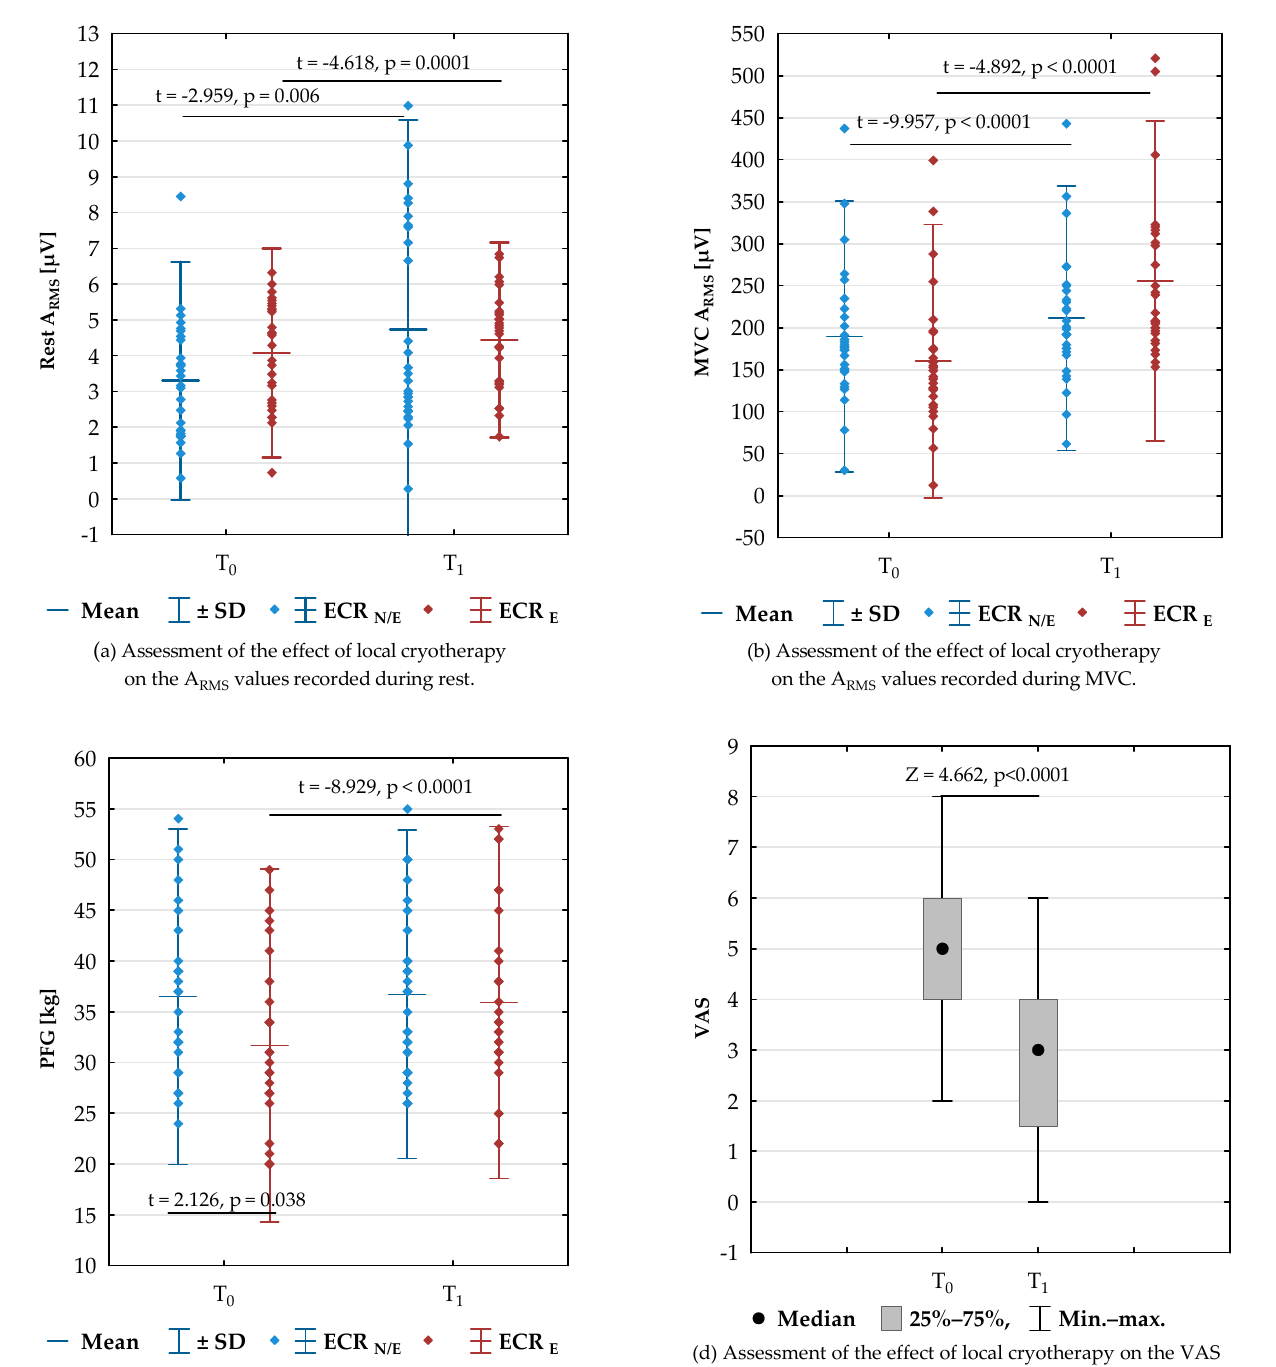
Figure 2. Assessment of the effect of local cryotherapy on the A RMS values recorded during rest ( a ) and MVC ( b ) and on the PFG ( c ) and VAS values ( d ). Legend: ECR—extensor carpi radialis longus and brevis muscles, LE —lateral epicondylitis, N/LE —healthy side, A RMS —root-mean-square amplitude, MVC—maximum voluntary contraction, PFG—pain-free grip, VAS—visual analogue scale.